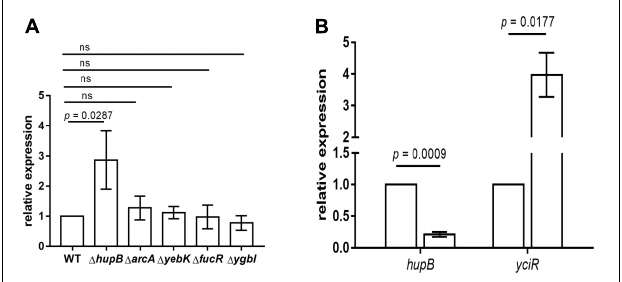
FIGURE 7 | yciR expression in different mutant strains of E. coli CFT073 and the intracellular regulation of HupB. (A) yciR expression influenced by hupB , arcA , yebK , fucR , and ygbI mutant strains. (B) Intracellular expression of hupB and yciR when the 5637 bladder cell line was infected with E. coli CFT073. Expression was normalized with the internal control gene gyrA. The error bars represent the mean ± SD , and three independent experiments were performed (two-tailed t